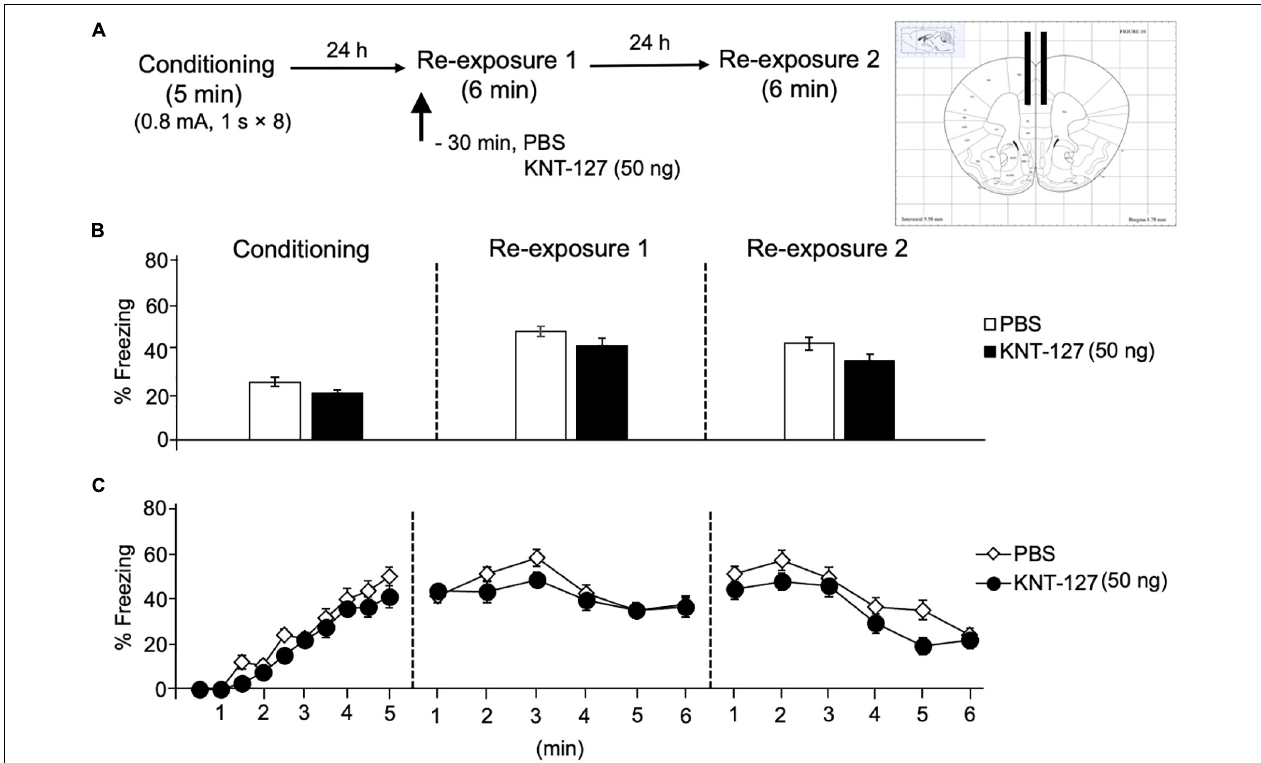
FIGURE 7 | Intra-PL administration of KNT-127 produced no significant effects on contextual fear memory. (A) Experimental design. Mice were bilaterally administered with PBS ( n = 12) or KNT-127 ( n = 9 for 50 ng) into the PL 30 min before reexposure 1 (6 min). Twenty-four hours after reexposure 1, a fear memory was tested in the same context for 6 min (reexposure 2). (B) Freezing rates of mice during conditioning, reexposures 1 and 2. KNT-127 does not reduce freezing rates during reexposures 1 and 2 when administered into the PL. (C) Time course of the freezing rates of mice during conditioning, reexposures 1 and 2. Data are expressed as the means ±